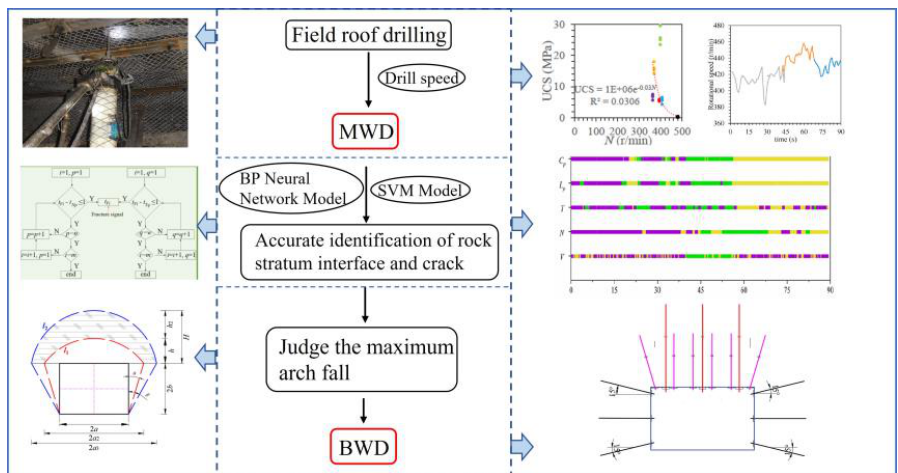
Figure 14. Flow of Support-While-Drilling.